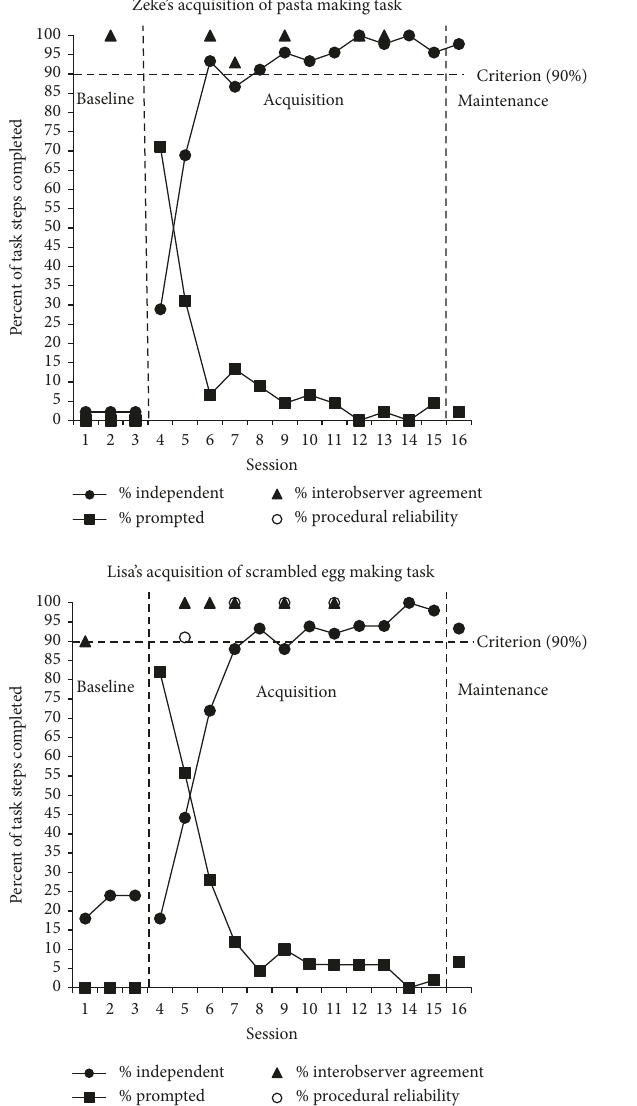
Figure 3: Percentage of task steps completed independently and with prompting: Zeke and